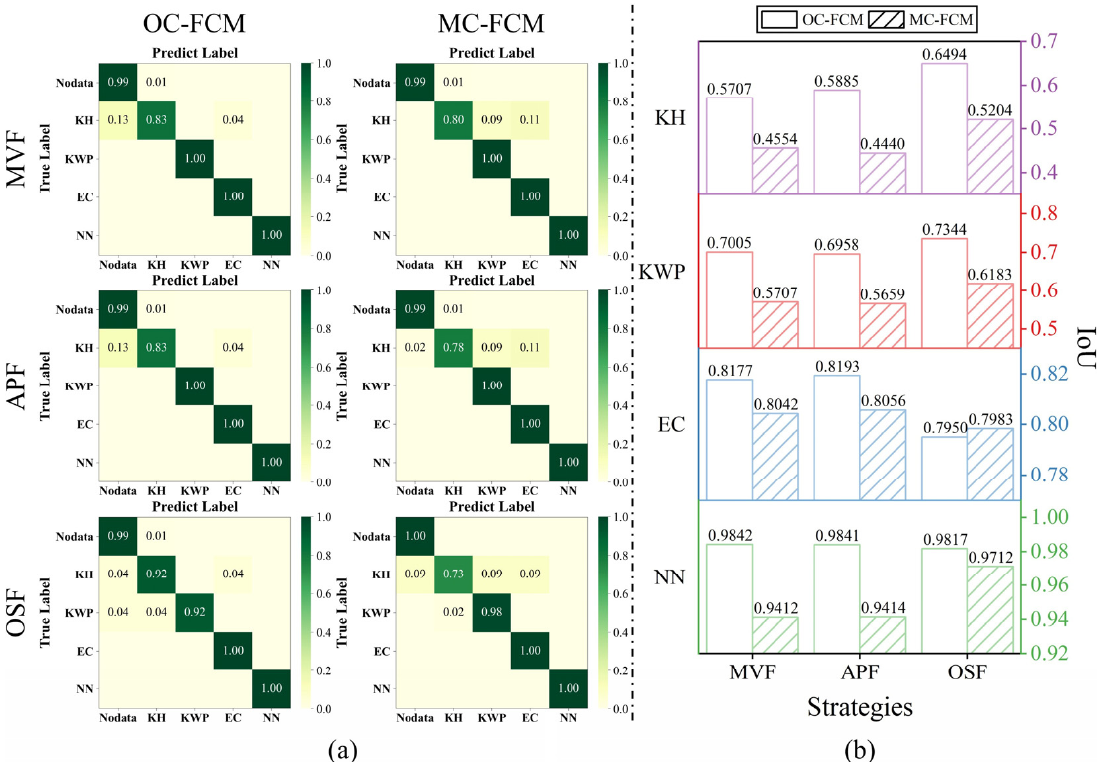
Figure 21. Differences in accuracy of the OC-FCM based on different fusion strategies for karst wetland vegetation. ( a ) normalized confusion matrix, ( b ) IoU.